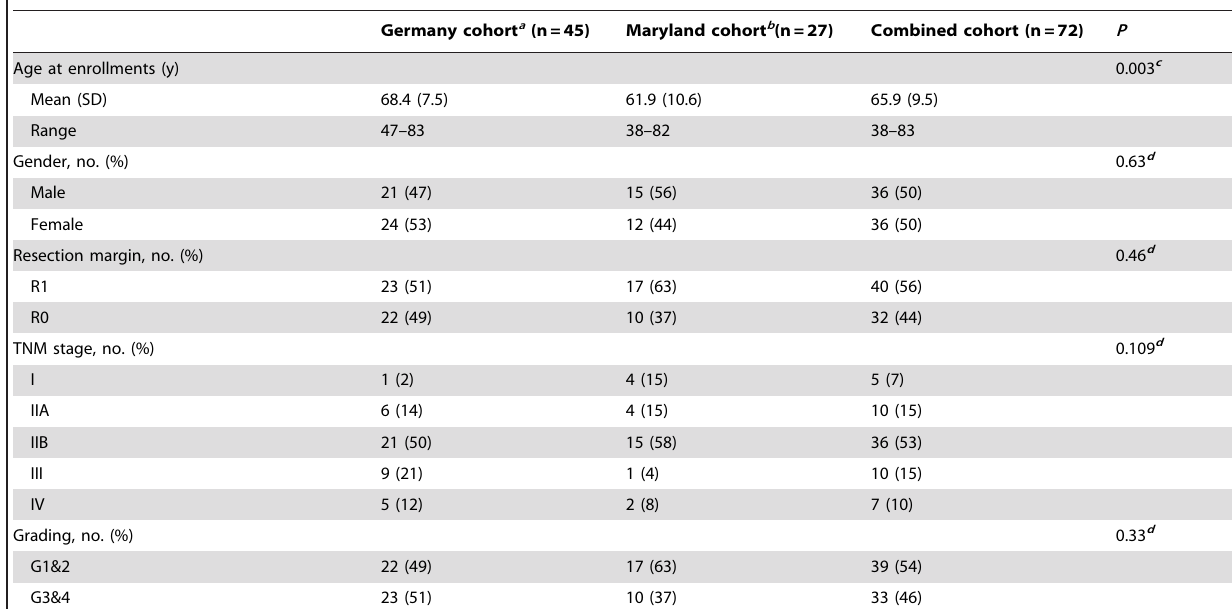
Table 1. Characteristics of